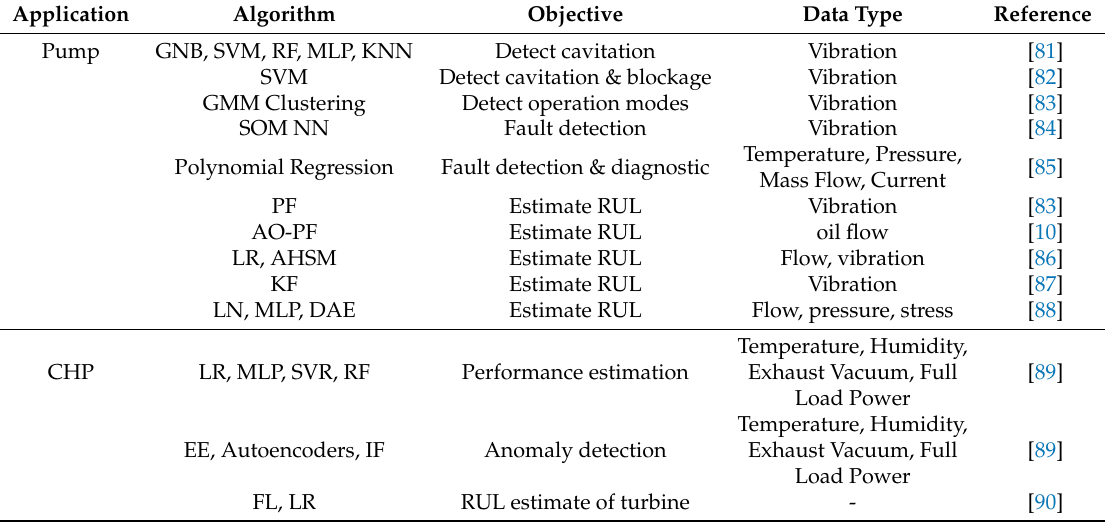
Table 5. An overview of relevant literature for the domain of PdM within all types of pumps and CHP units. It is not an exhaustive list, but it can give insight into where more efforts should be